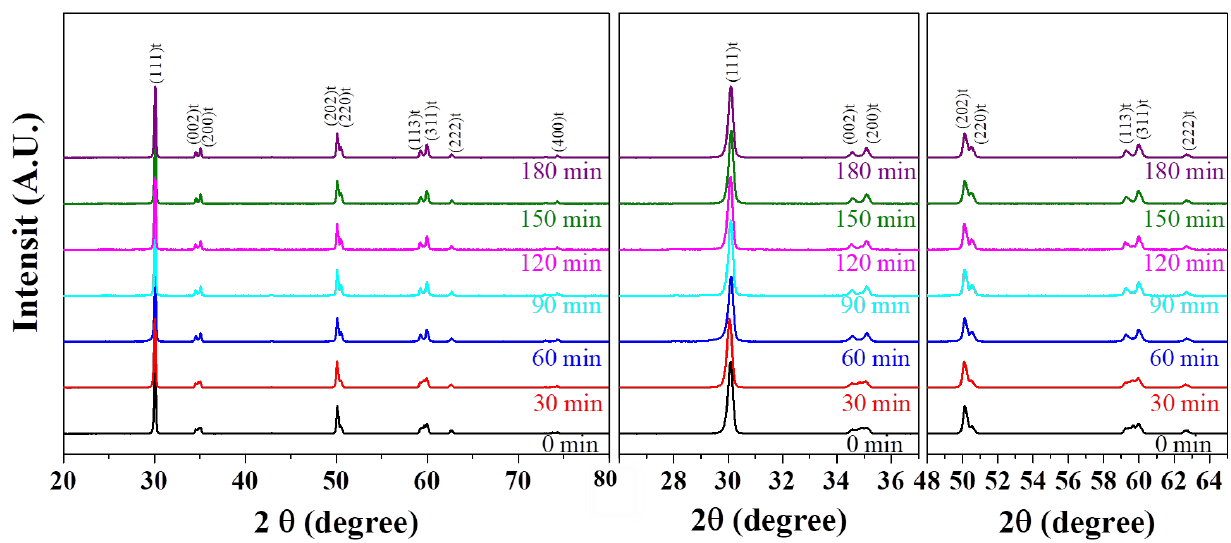
Figure 6. XRD patterns of 3YSZ 3D-printed sintered body according to sintering time.